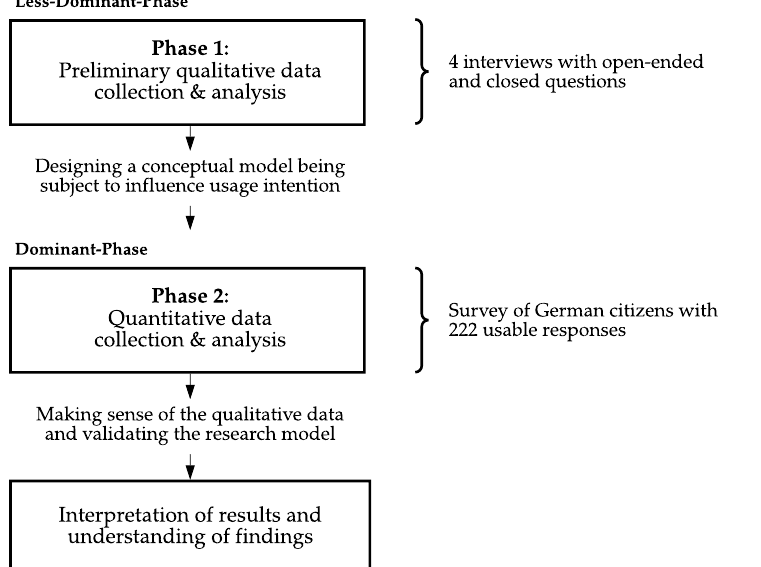
Figure 4. The mixed-methods multistrand exploratory-explanatory research with the dominant-less dominant